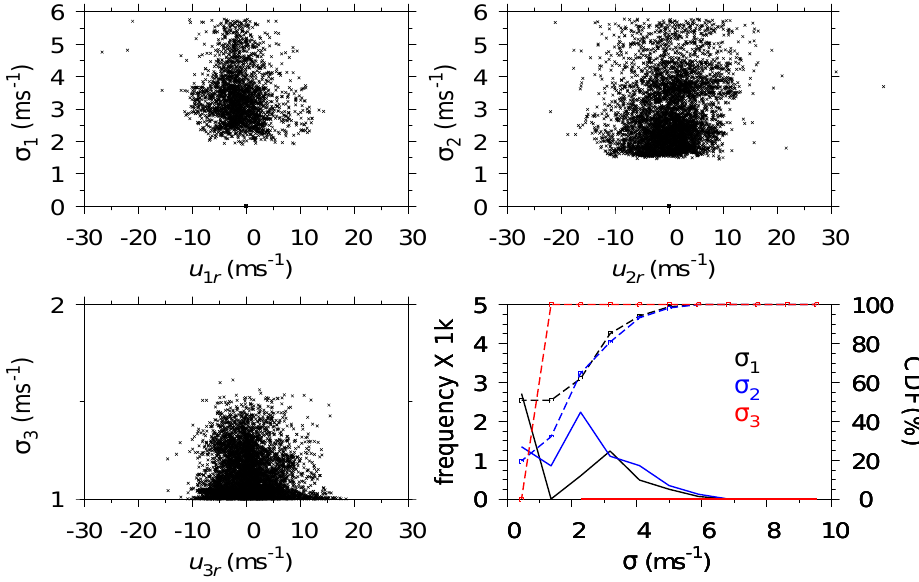
Fig. 6. This figure shows the overall distributions of the errors for gridded velocities that have passed our quality control. The scatter plots show the behavior of the error as a function of its associated relative eigen-velocity ( u r = u − v s , where v s is the storm velocity and u is the gridded eigen-velocity). The lower right panel shows histograms of the errors (solid lines) and their corresponding cumulative distribution functions (dashed lines).